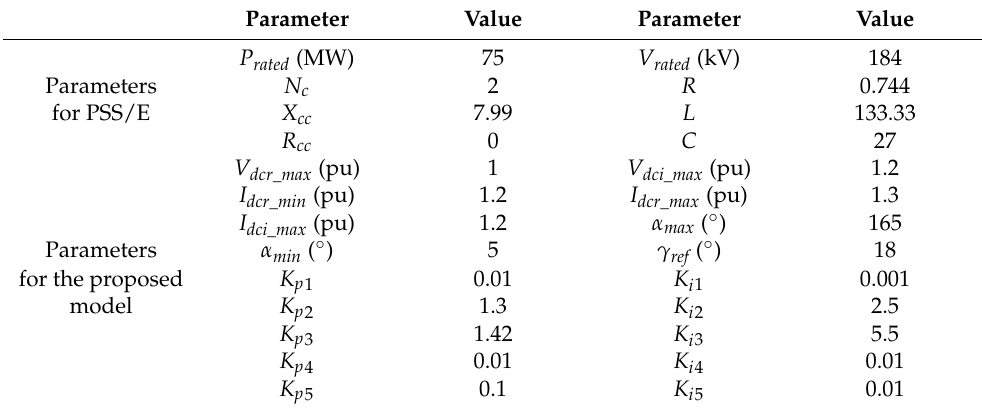
Table 6. Modified values of the generic models for the Jeju ‐ Haenam HVDC system.